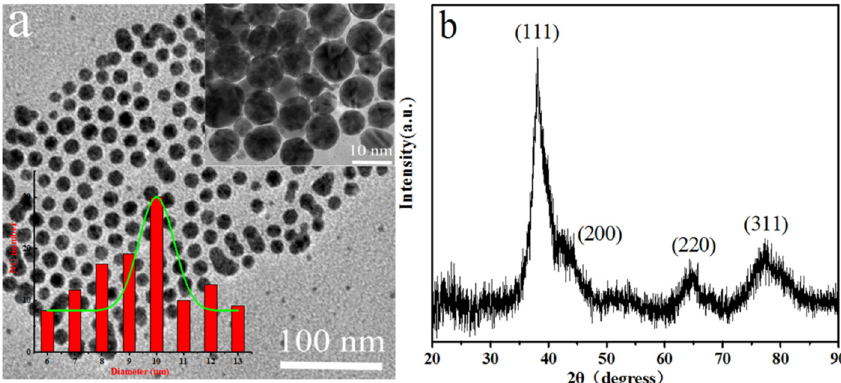
Figure 2. ( a ) TEM images of the as-synthesized Ag nanoparticles and the corresponding size distribution of as-synthesized Ag nanoparticles (inset); ( b ) XRD pattern of as-synthesized Ag nanoparticles.